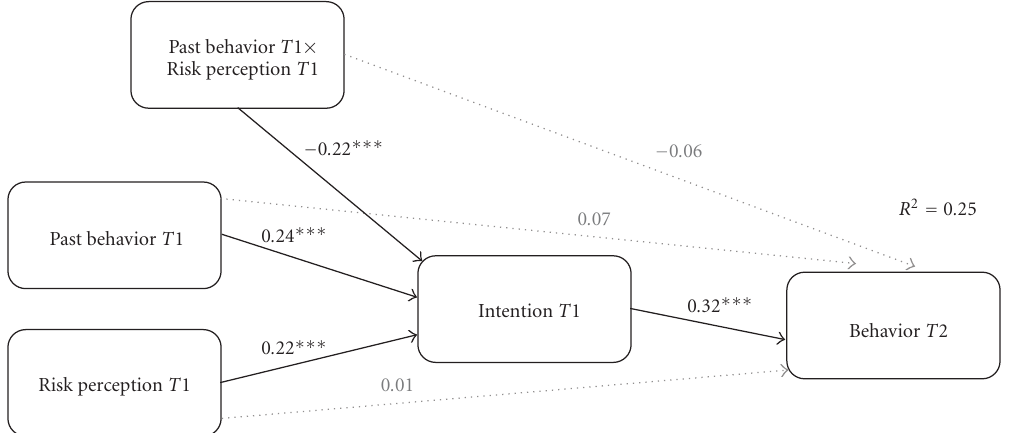
Figure 2: Moderated mediation analysis ( N = 552). Past behavior T 1 moderates the indirect e ff ect of risk perception T 1 via intention T 1 on behavior T 2. Note: ∗∗∗ P < .